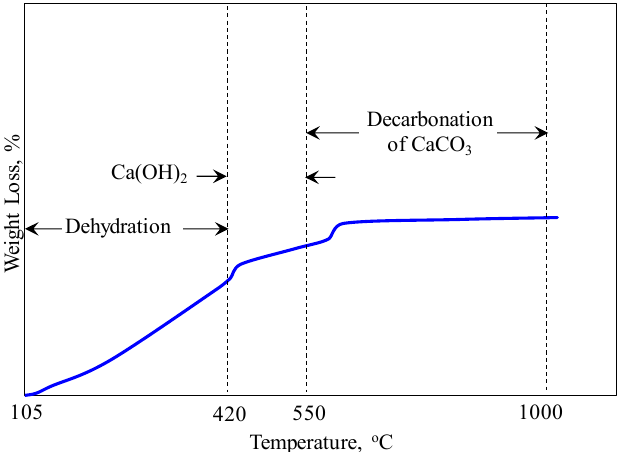
Figure 3. Typical thermogravimetric analysis (TGA) thermogram showing weight loss vs. temperature curve of cement pastes.